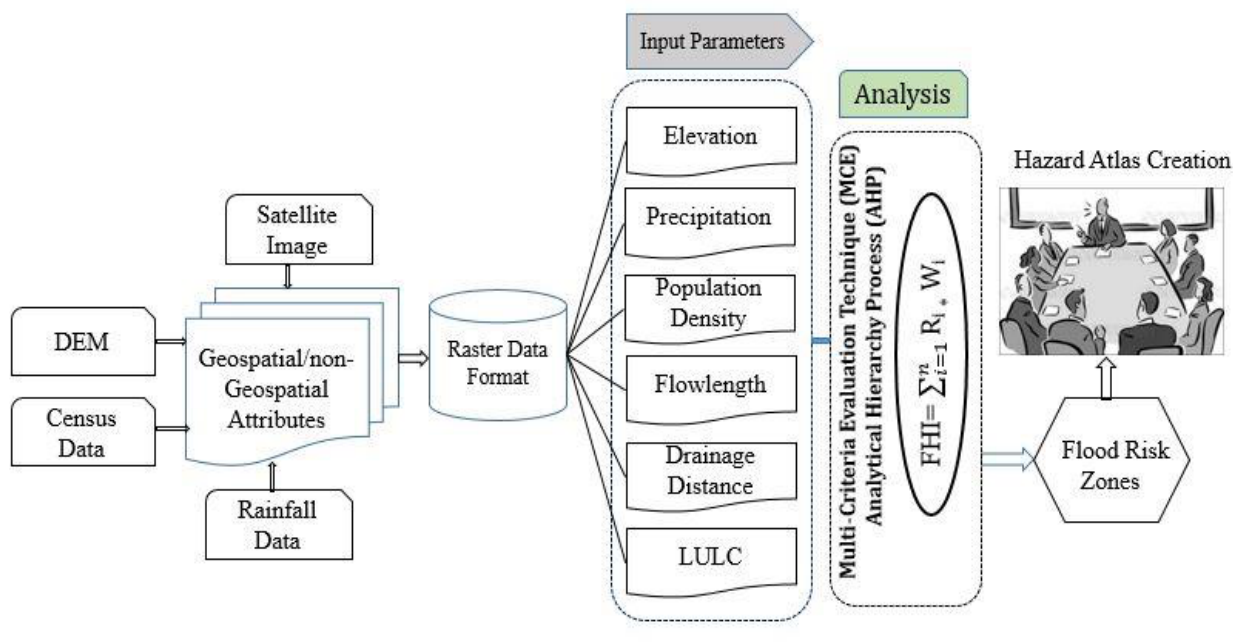
Figure 2: Methodological framework for the flood-hazard zonation.